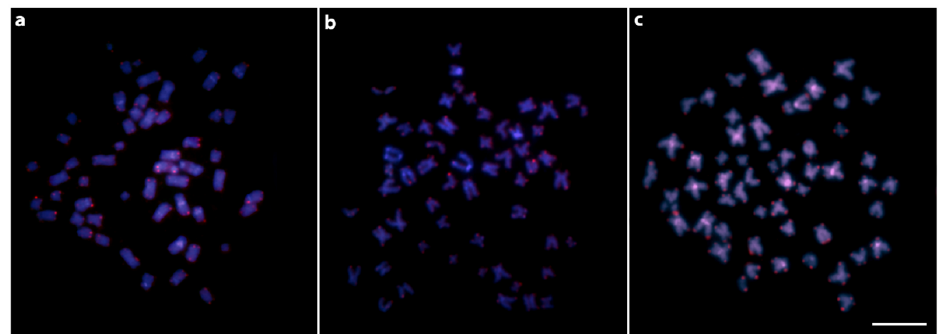
Figure A1. Distribution of the telomeric probe (TTAGGG) n directly labeled with Cy3-dUTP (red) and hybridized against the DAPI-counterstained (blue) chromosomes of Harttia dissidens ( a ), H. guianensis ( b ) and Harttia sp. 3 ( c ). Bar scale = 10 µm.